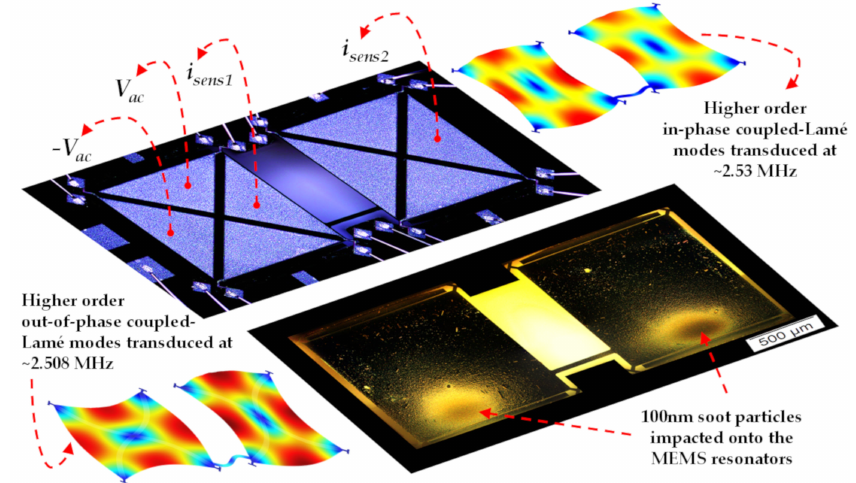
Figure 2. Illustration of the actuation and transduction mechanism used in the coupled MEMS resonators for the out-of-phase and in-phase coupled Lam é modes with the 100 nanometre diameter soot particles impacted onto the